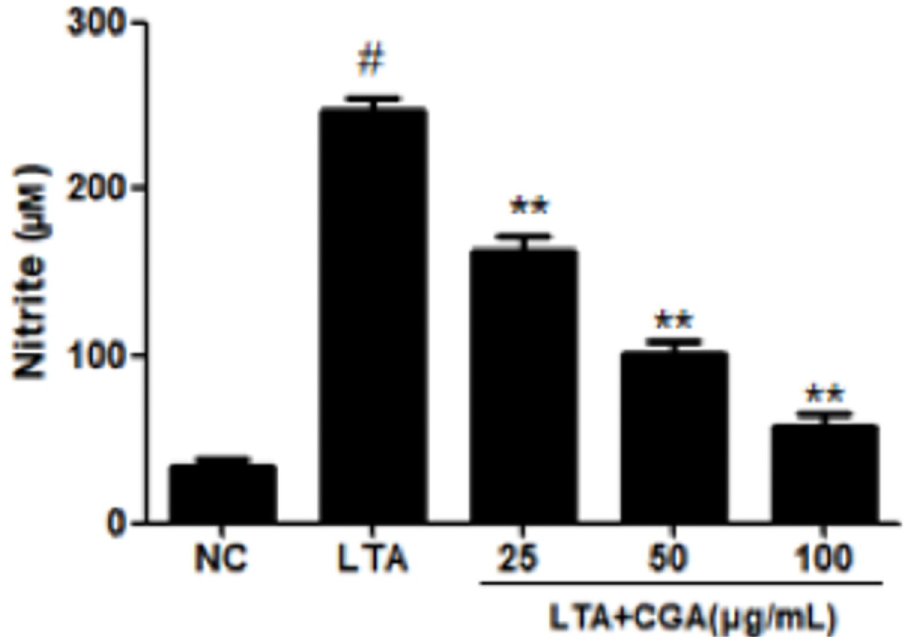
Fig 5. Effect of chlorogenic acid (CGA) on Nitric oxide (NO) production. The values presented are the mean ± SE of three independent experiments. # p < 0.05 vs. control group; �� p < 0.01 vs. LTA group. NC: normal control; LTA: lipoteichoic acid; LTA+CGA: lipoteichoic acid and chlorogenic acid.